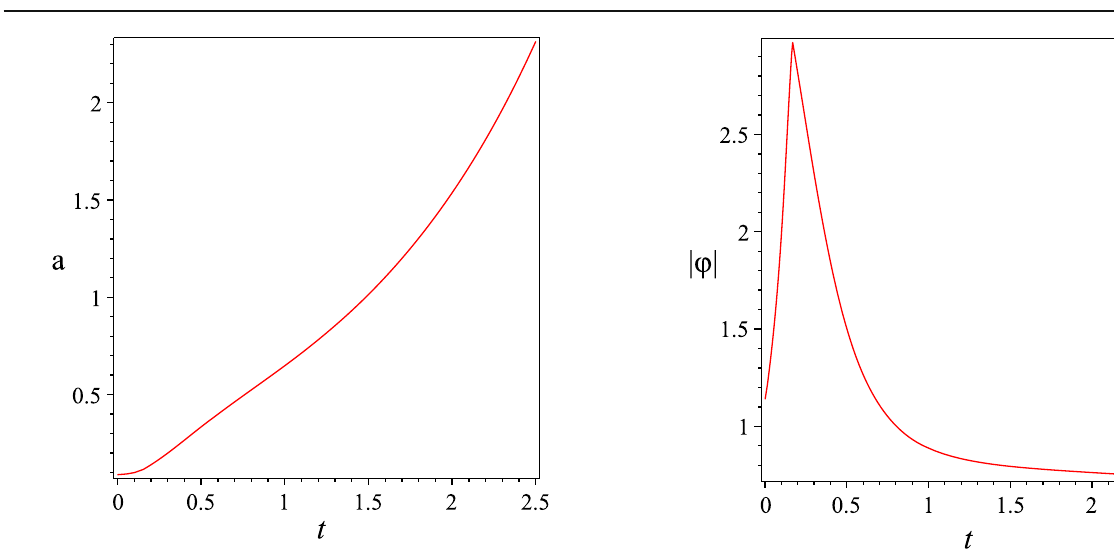
Fig. 4 The evolution of the modulus of torsion φ with respect to time